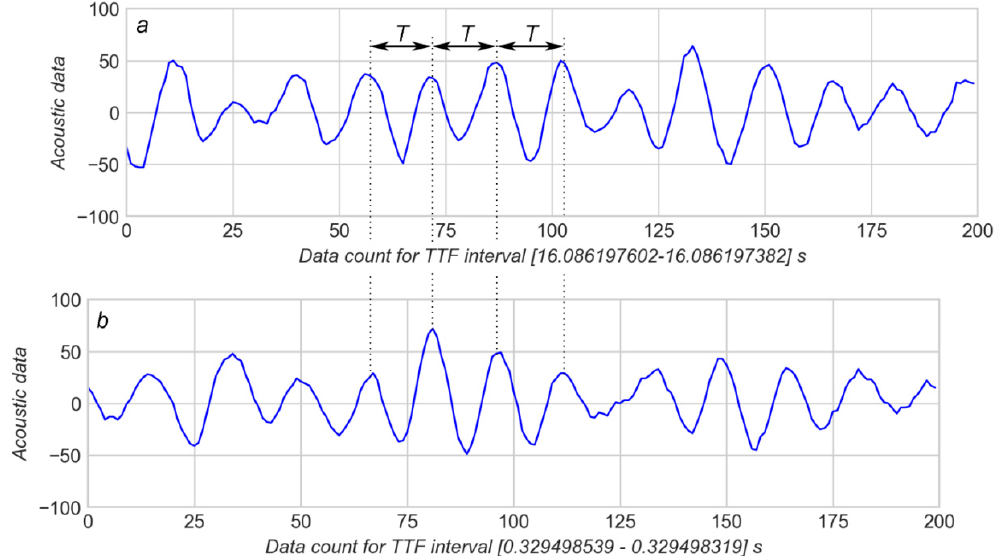
Figure 8. Comparison of frequency of AD splashes far from ( a ) and near ( b ) the “earthquake”: ( a )—first 200 AD values in the dashed window in Figure 5a; ( b )—first 200 AD values from arrow 5 in Figure 1.